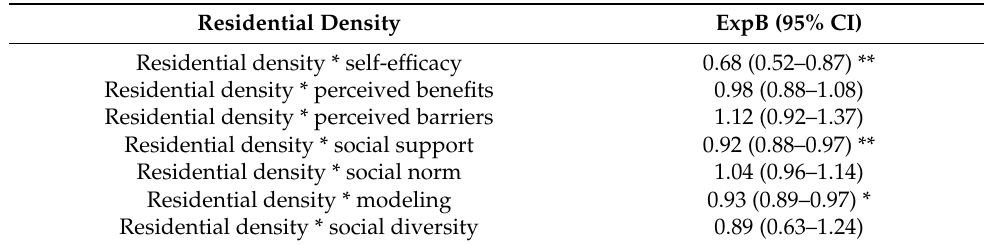
Table A2. Single interactions models related to active